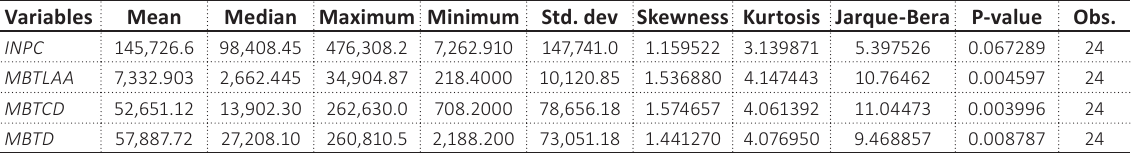
Table 2. ADF test result at the second difference: intercept only